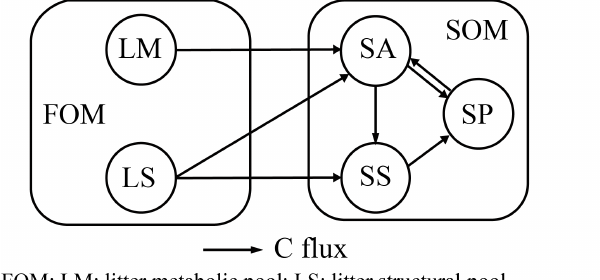
Figure 2. Pools and fluxes of the CENTURY and PRIM